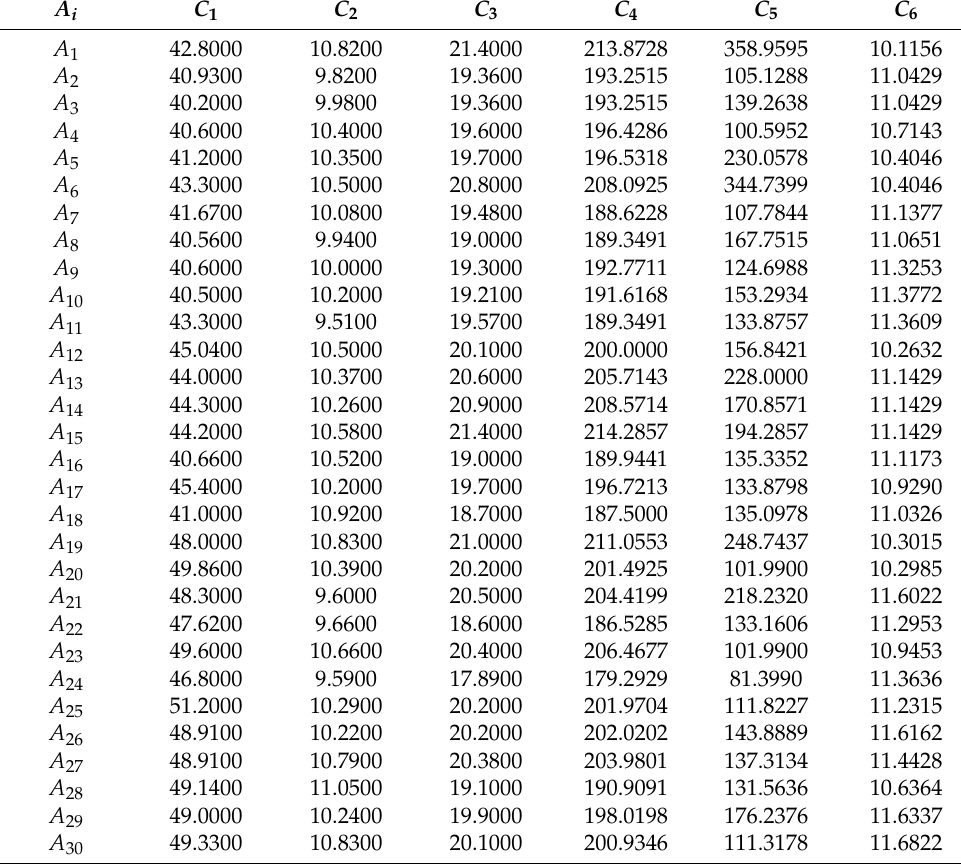
Table 1. Decision matrix including values of criteria for evaluated